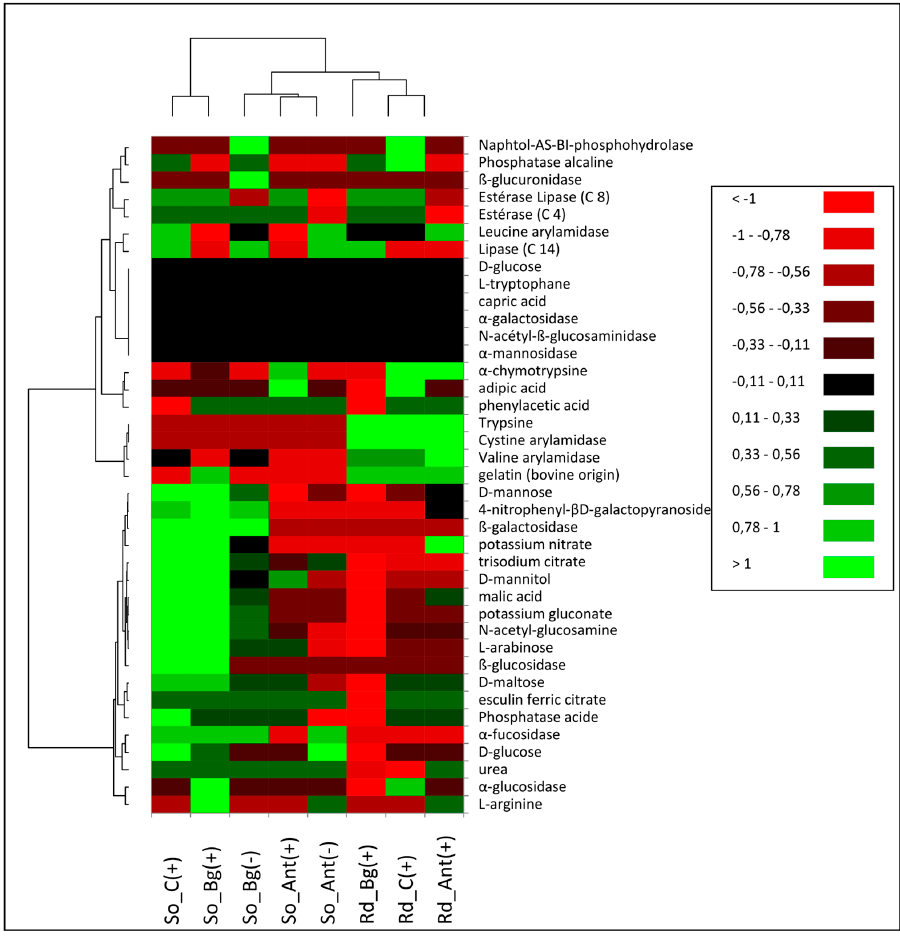
Figure 6. Heatmap showing the parameters of metabolism and enzymatic activity of the rice weevil microbiota and the lesser grain borer; So: S. oryzae , Rd: R. dominica , C: control, Bg: background, Ant: antibiotic, +: alive, –: dead.